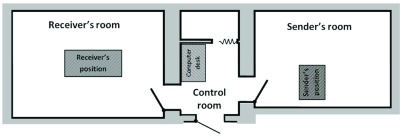
Floor plan showing rooms used in the experiment.